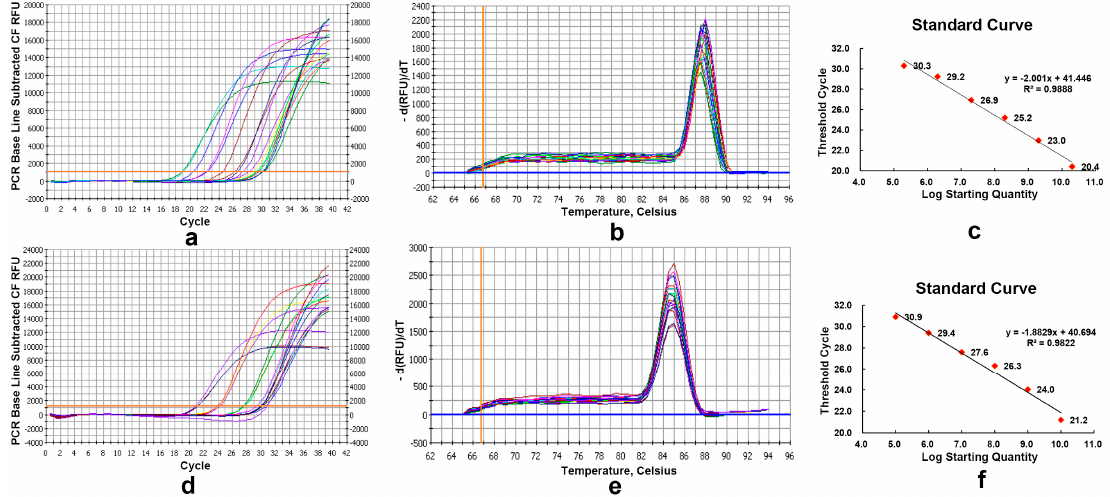
Figure 4. Fluorescence amplification curve ( a ), melting curve ( b ), and standard curve ( c ) of Xoo ; fluorescence amplification curve ( d ), melting curve ( e ), and standard curve ( f ) of Xoc .